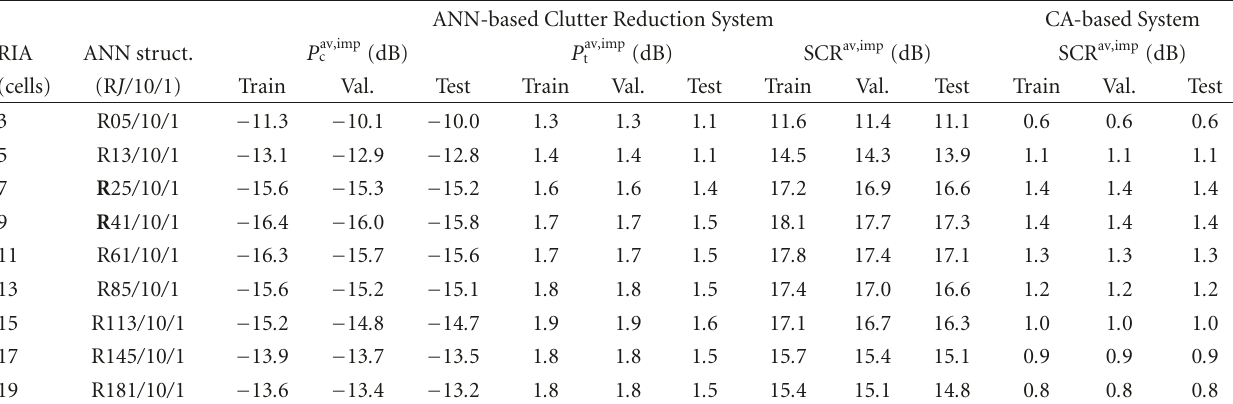
Table 3: Performance evaluation of CA- and ANN-based clutter reduction systems with di ff erent number of integrated cells, J , considering a 2D (rhombus (R)) integration mode.